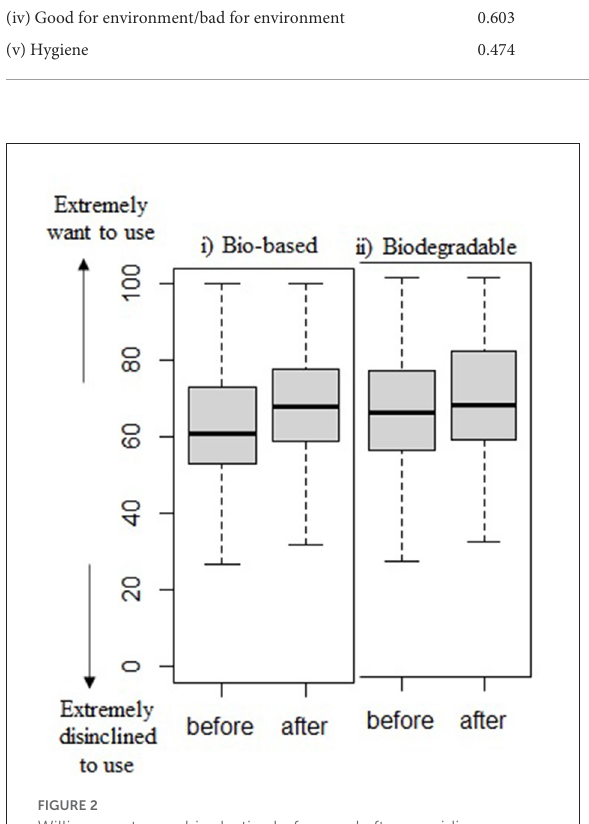
FIGURE2 Willingness to use bioplastics before and after providing